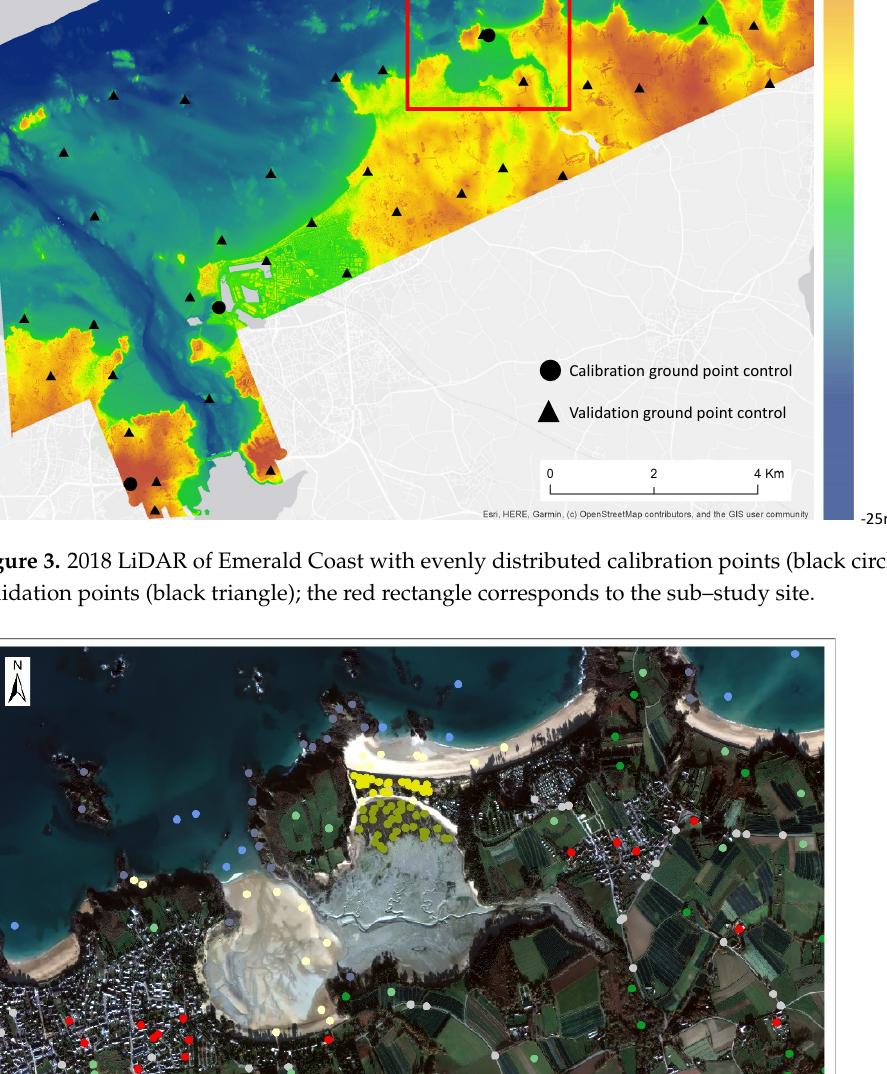
Figure 3. 2018 LiDAR of Emerald Coast with evenly distributed calibration points (black circle) and validation points (black triangle); the red rectangle corresponds to the sub–study site.